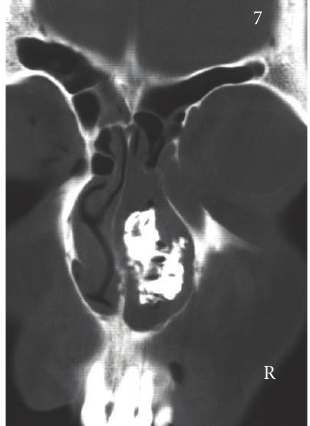
Figure 2: Coronal CT showing a calcified space-consuming lesion occupying much of the right nasal cavity.